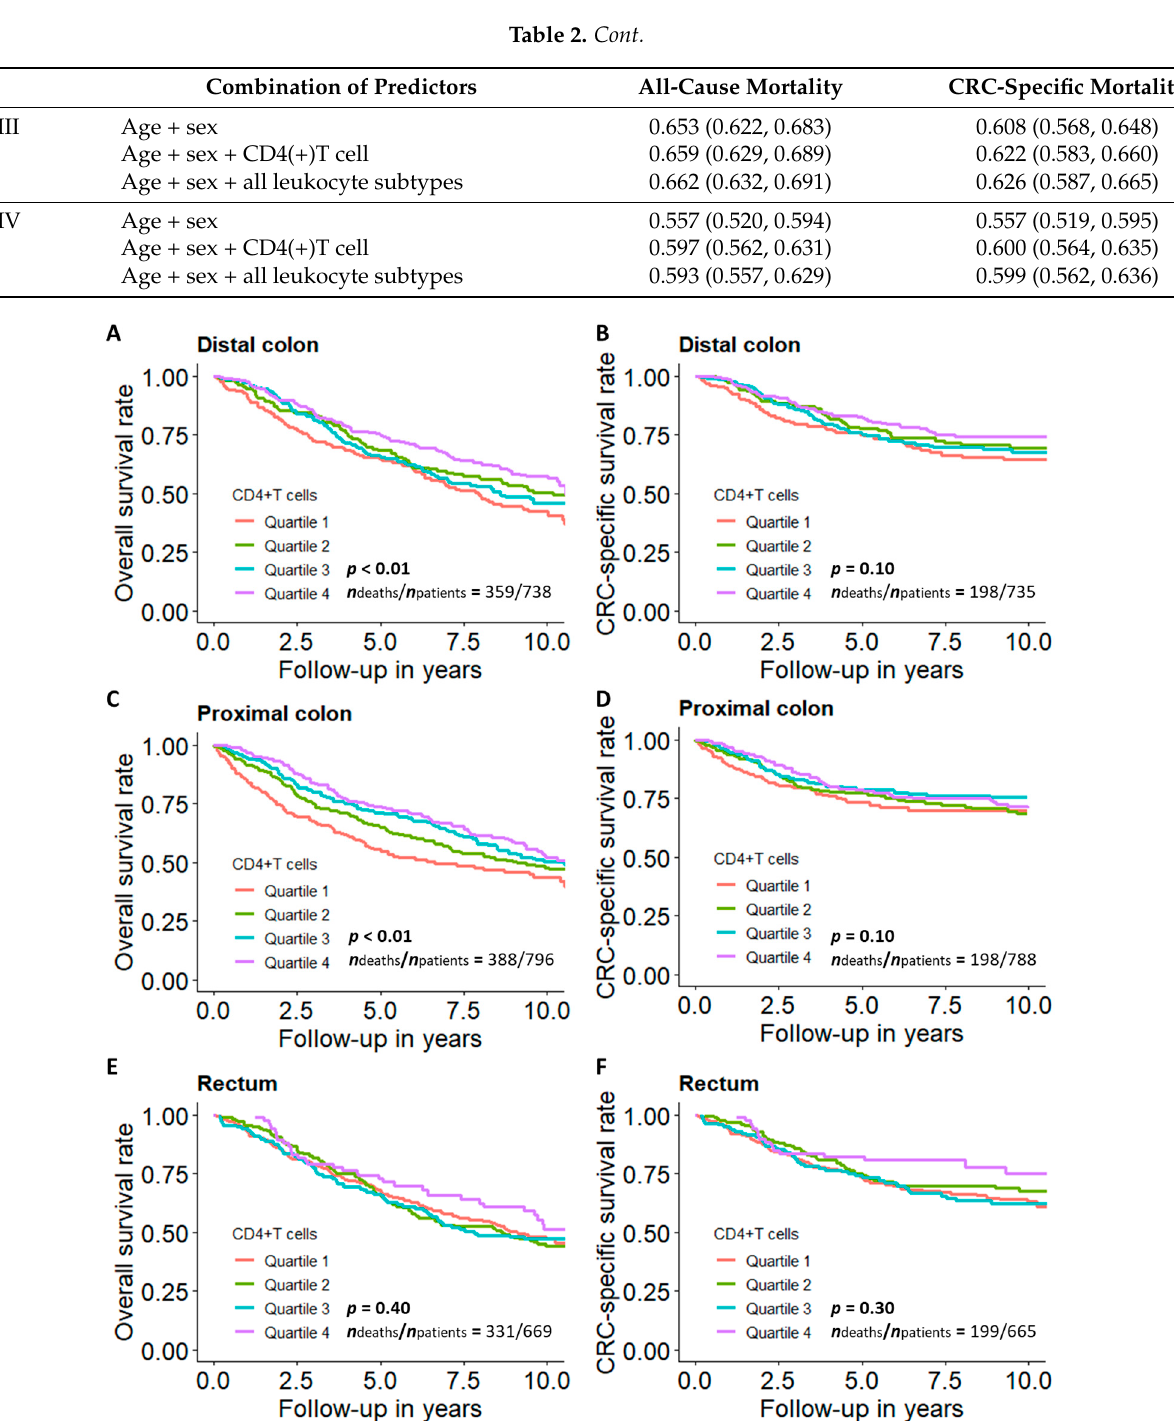
Figure 4. Survival curves for CRC patients across quartiles of CD4+ T cell proportions by tumor subsite. ( A ) Overall and ( B ) CRC-specific survival curve among patients with distal colon cancer; ( C ) overall and ( D ) CRC-specific survival curve among patients with proximal colon cancer; ( E ) overall and ( F ) CRC-specific survival curve among patients with rectal cancer. Note: Survival curves were adjusted for age, sex, tumor stage, timing of blood sampling and batch. p values were derived from G-rho family of tests. Quartile 1: lowest quartile; Quartile 4: highest